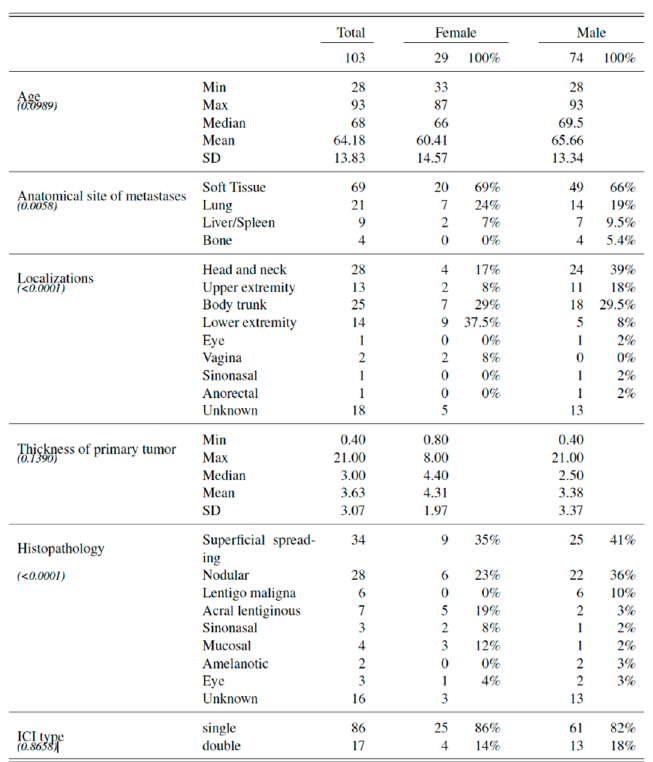
Figure 1. Baseline characteristics of all included female and male patients with advanced melanoma before initiation of immune checkpoint inhibition.